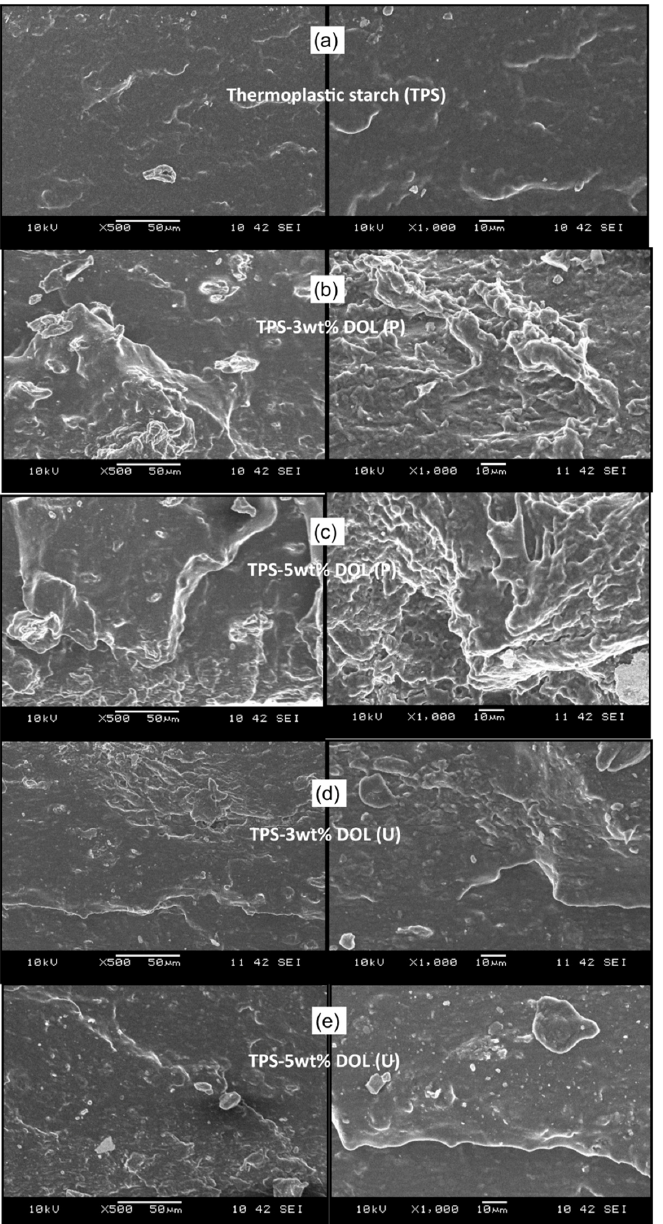
Figure 10. The SEM images of the tensile fractured surface of the (a) TPS film, ( b ) TPS-3 wt% DOL (P), ( c ) TPS-3 wt% DOL (U), ( d ) TPS-5 wt% DOL (P), and ( e ) TPS-5 wt% DOL (U) biocomposite films at 500× magnification ( left ) and 1000× magnification ( right ). Reprinted with permission from Ref. [12].